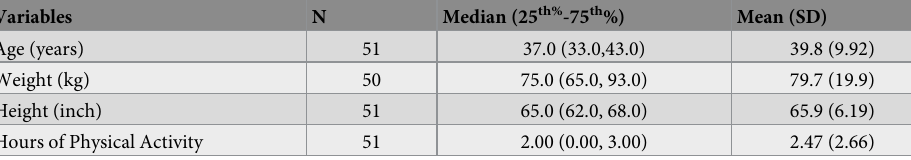
Table 3. Characteristics of the